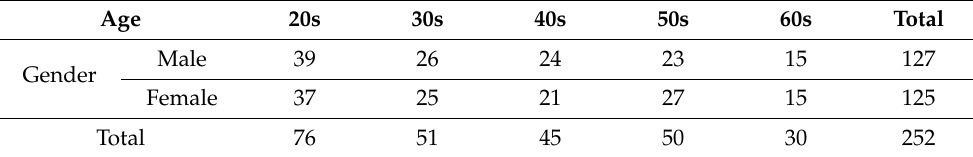
Table 1. Distribution of